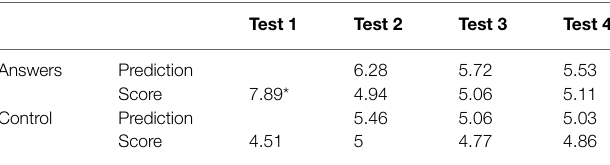
TABLE 1 | Study 1 scores and predictions.